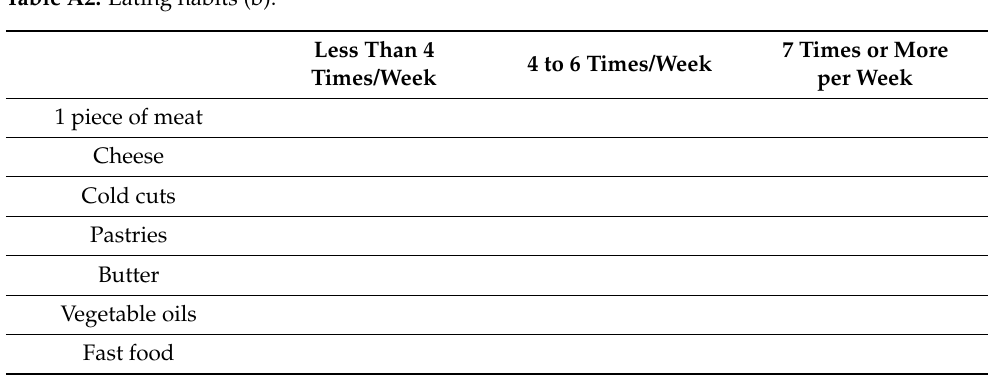
Table A2. Eating habits (b).